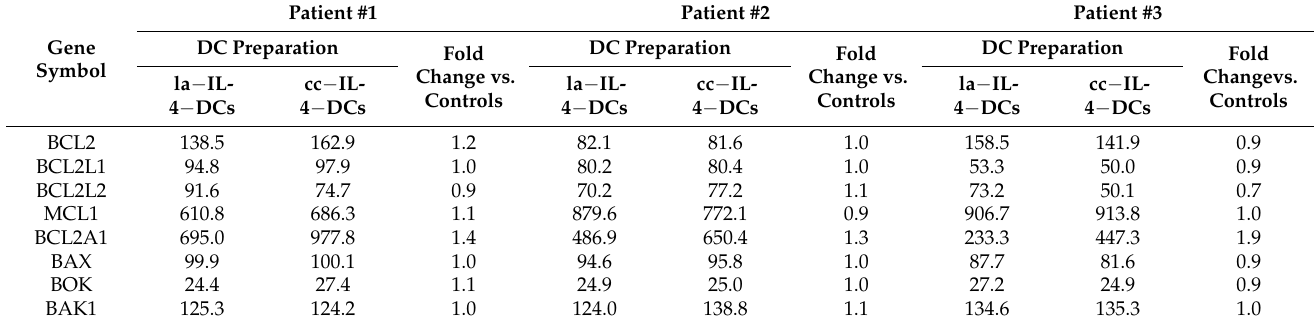
Table 2. Comparison of representative expression of BCL2 genes in low − adherent − IL-4DCs and cluster − controlled IL- 4DCs.